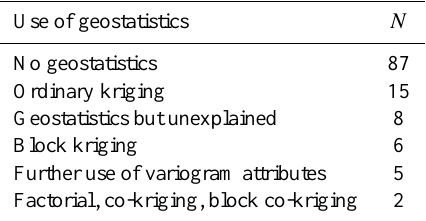
Table 3. Use of geostatistics in the zoning studies carried out over the 2002–2013 period (see Fig. 2).